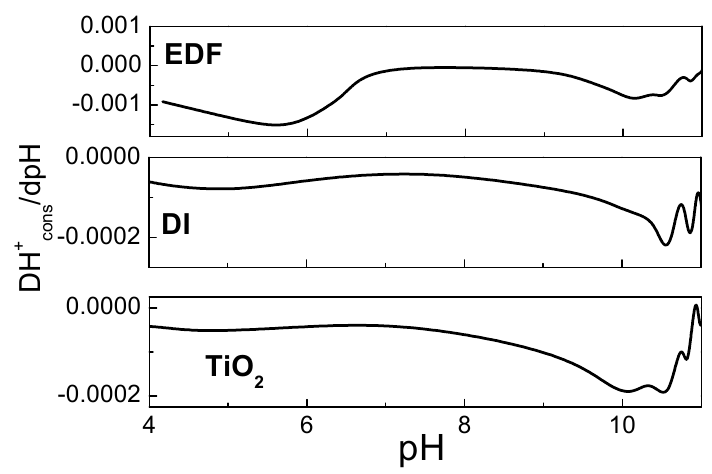
Figure 10. Di ff erential curves of the H + consumption for each sample Figure 10. Differential curves of the H + consumption for each sample studied.